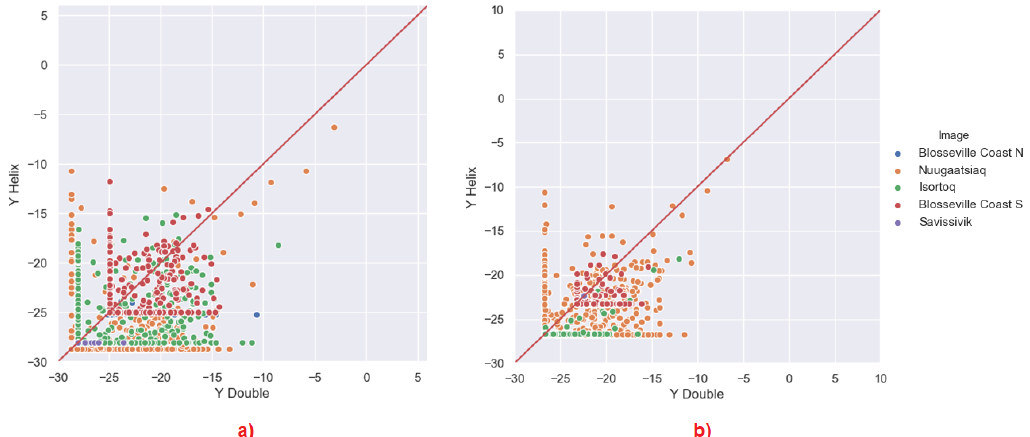
Figure 25. ( a ) Iceberg double bounce scattering, helix scattering plot in a 5 × 5 window, ( b ) 11 × 11 window. The majority of icebergs tend to show significant double bounce. Colour legend indicates image. Dots indicate icebergs. All values are in dB.